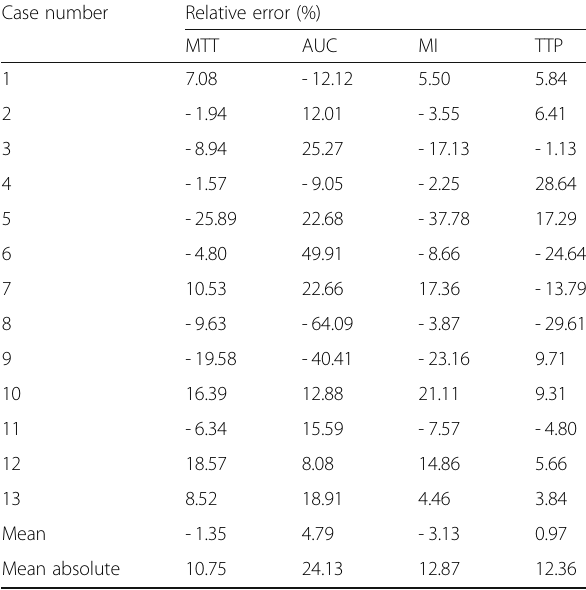
the commercial software for the analysed parameters, including mean relative error for every parameter and mean relative error considering the absolute